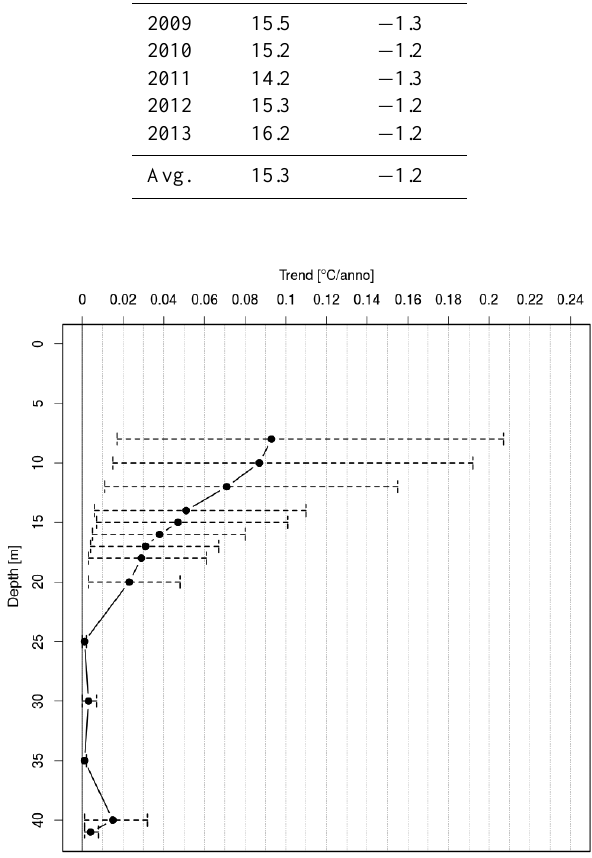
Figure 8. Warming rate calculated over the period 2009–2013 be- low 8m of depth in the borehole DP as a function of depth. Black dots represent linear trends as ◦ Cyr − 1 . The uncertainty of trend values is represented by the dashed bars, which indicate the lower and upper boundaries of the 95% confidence interval of the fitting model (see Sect. 2.5 for